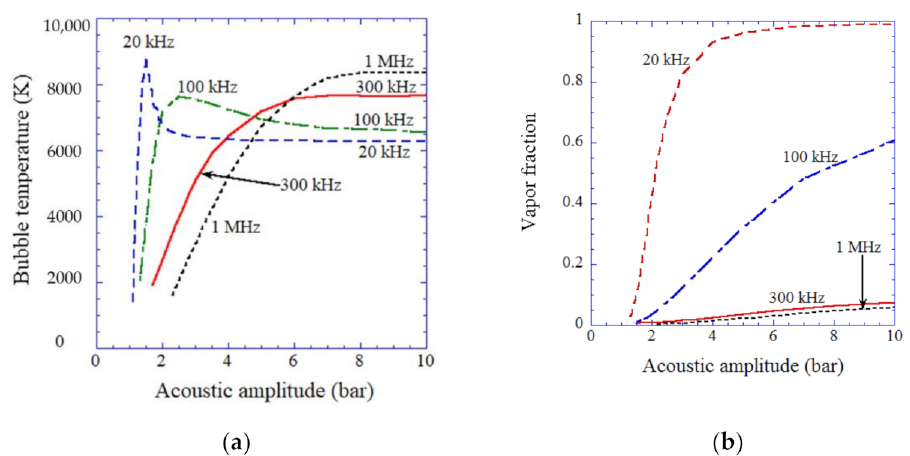
Figure 5. The results of the numerical simulations as a function of acoustic amplitude for various ultrasonic frequencies for the first collapse of an isolated air bubble [41]. The ambient bubble radii are 5 µ m for 20 kHz, 3.5 µ m for 100 and 300 kHz, and 1 µ m for 1 MHz. ( a ) The temperature inside a bubble at the violent collapse. ( b ) The molar fraction of water vapor inside a bubble at the end of the violent collapse. Copyright 2007, with permission of AIP